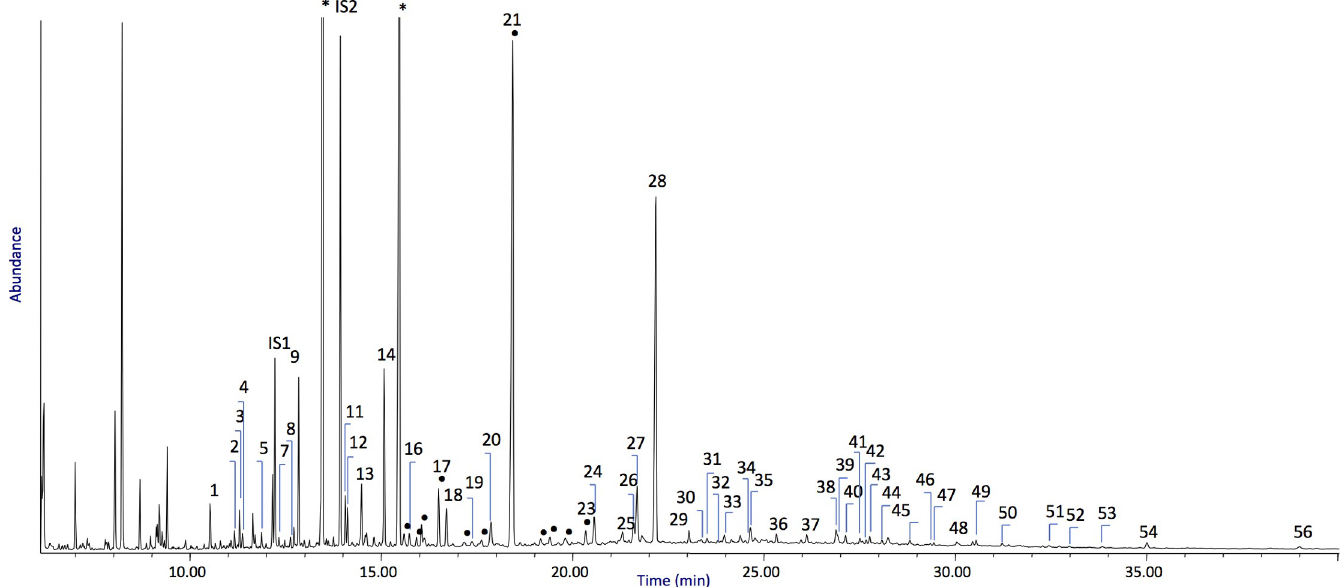
Fig 7. Chromatographic profile obtained for lipid-resinous fraction of sample F1. The numbers refer to Table 8. IS1 = hexadecane, IS2 = tridecanoic acid, •: branched fatty acids, � : phthalate contamination.